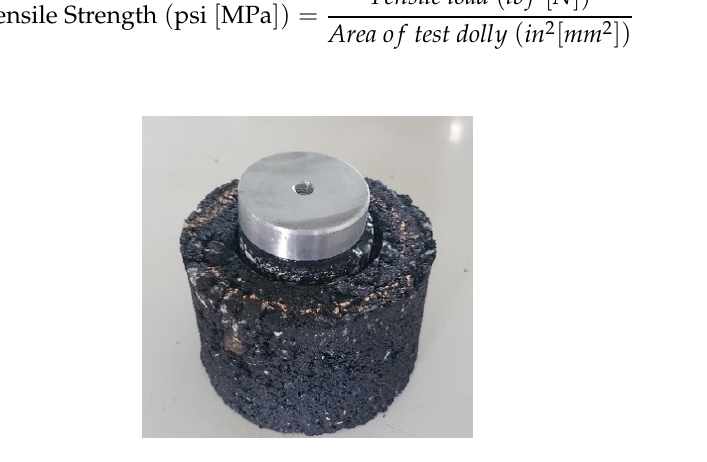
Figure 4. A dolly attaches to a Marshall sample.